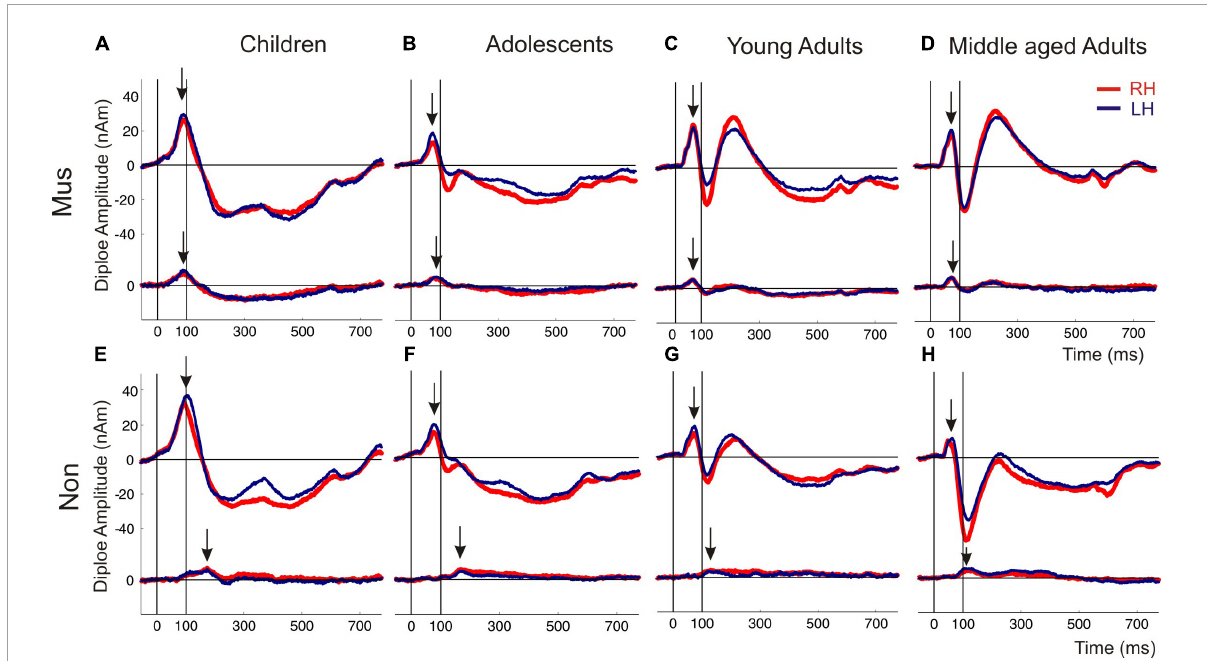
FIGURE3 Auditory evoked fields in response to instrumental and harmonic complex sounds. The superior curve shows the auditory evoked P1-N1-P2 complex followed by a sustained field and the offset about 600 ms after tone onset. The inferior curve depicts the coactivated response of the orbitofrontal cortex, seeded with fixed coordinates in the center of the BA10 region. The subpanels (A–D) show the responses of the musicians, subpanel (E–H) those of the non-musicians [ (A,E) children; (B,F) adolescents; (C,G) young adults; (D,H) middle-aged adults]. Arrows indicate the first onset peak of the auditory and orbitofrontal response, respectively. Red curve, right hemisphere; dark blue curve, left